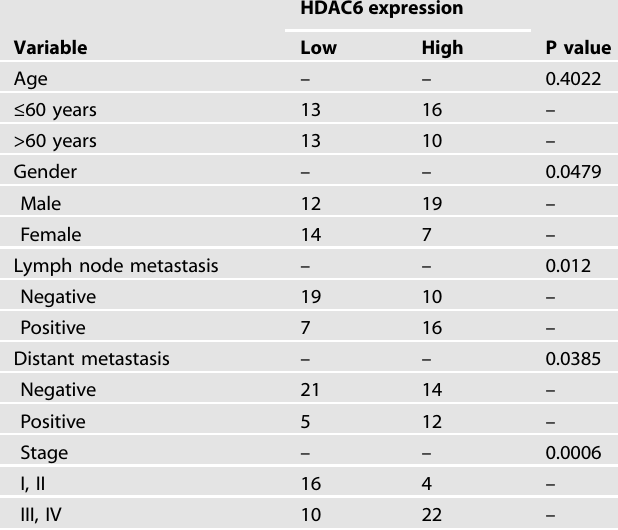
Table 1. Relationship of HDAC6 expression with metastasis ( χ 2